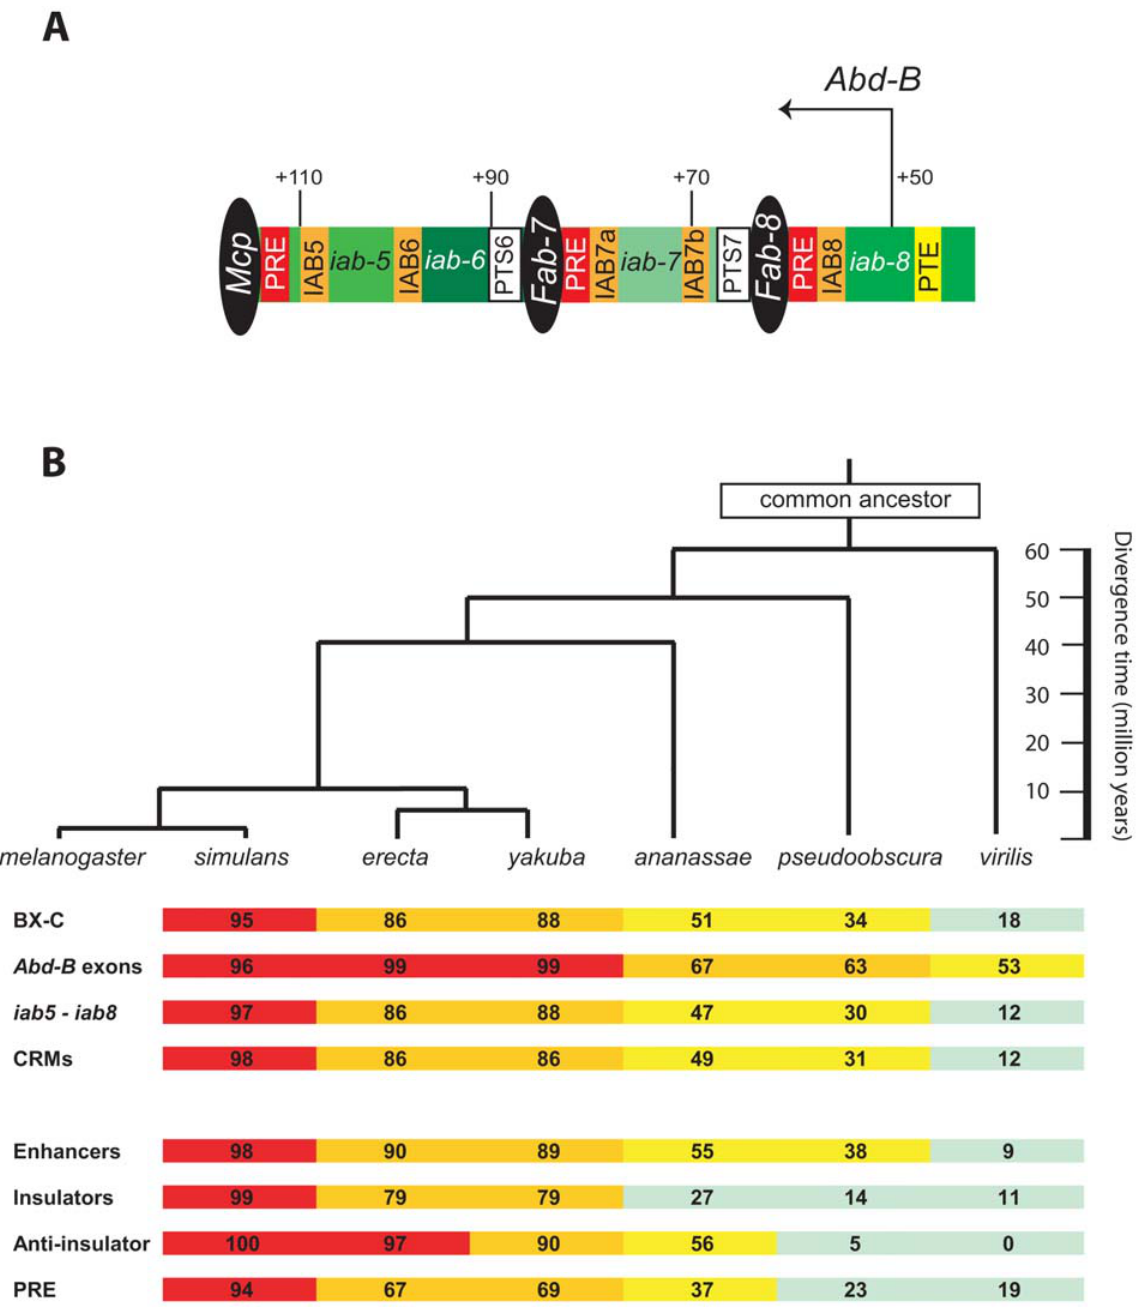
Figure 1. Molecular organization and sequence conservation of the 3 9 regulatory regions for the Abdominal-B gene in Drosophila melanogaster . (A) An extensive array of 3 9 cis -regulatory modules directs the embryonic expression of the Abd-B gene. The Abd-B transcription start site is indicated by leftward arrow. The cis -regulatory iab regions ( iab5–8 ) are indicated as shaded rectangles and the characterized enhancers in the individual iab regions IAB5, IAB6, IAB7a, IAB7b, and IAB8 are specified with orange rectangles. The positions of the Fab-7, Fab-8, and Mcp insulators, which functionally separate the iab regions, are indicated as black ellipses. The promoter targeting sequence (PTS) modules (white rectangles), Polycomb response elements (PREs) (red rectangles) and promoter tethering element (PTE) (yellow rectangle) are also shown. Numbers above the line refer to kilobase positions in DNA sequence accession number: U31961. (B) A consensus tree illustrating evolutionary relationships among Drosophila species and sequence conservation at the Abd-B gene. Tree indicates evolutionary relationships between Drosophila species [67]. Level of conservation between sequences from D. melanogaster and six other Drosophila species is indicated by color code: . 90% red, 60–90% orange, 30– 60% yellow, , 30% green (calculation for conservation is detailed in Materials and Methods). The sequences listed are the entire bithorax complex (BX-C), exons from the Abd-B gene ( Abd-B exons), the complete 3 9 chromosomal region that directs Abd-B gene expression during embryonic development ( iab5–iab8 ), and the defined CRMs from the iab5–8 regions (CRMs). The CRMs are further sub-divided to show the level of conservation among the enhancer, insulator, anti-insulator and PRE modules and are described in more detail in Table S1.